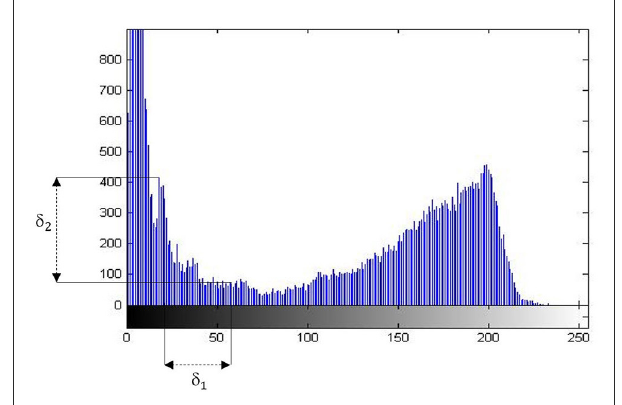
FIGURE1 The histogram of image depicts the distance and